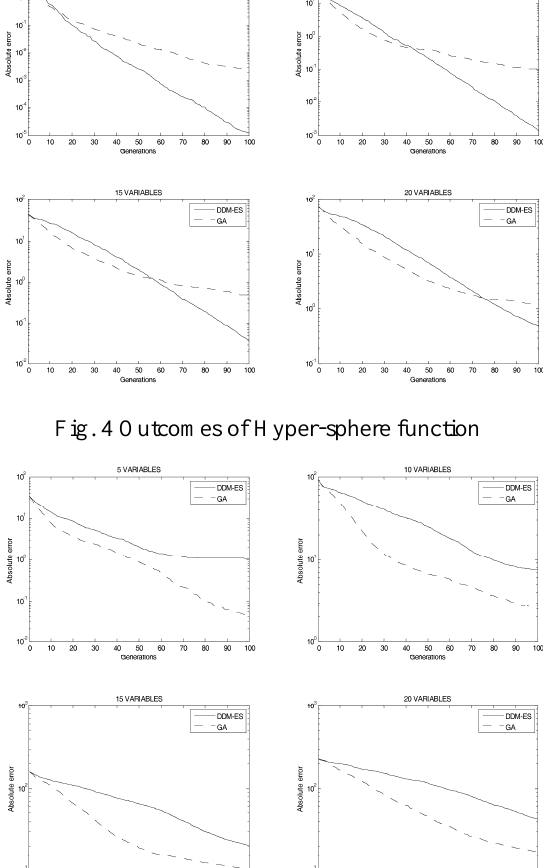
Table 3. Parameters for GA